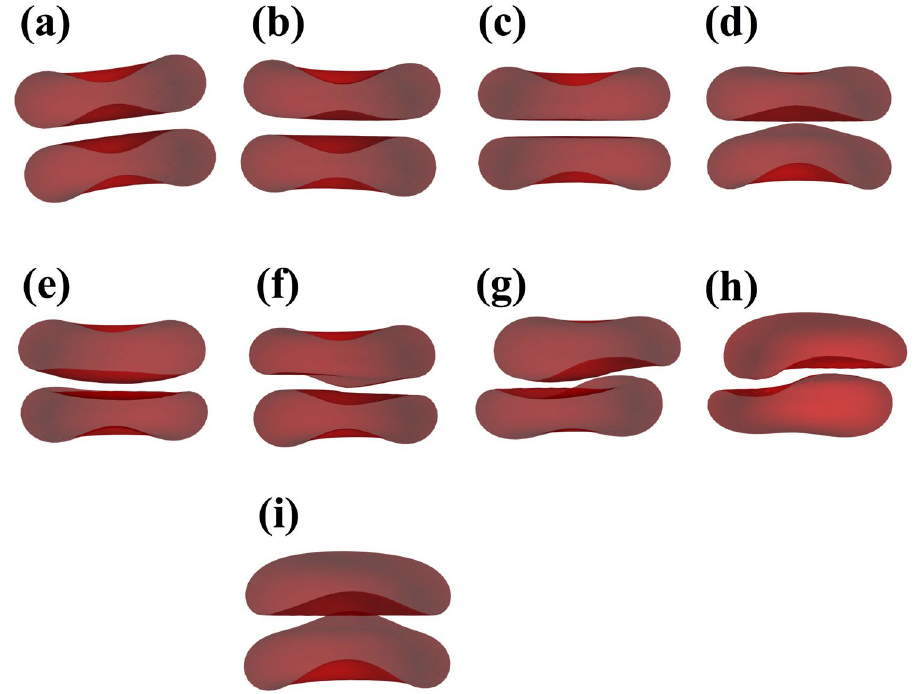
Figure 5. 3D simulations of interacting RBC doublets. ( a – h ) Identical RBCs ( ν 1 = ν 2 = 0.65) for an increasing interaction energy (in μ J/m 2 : ( a ) ε ad = 0.98, ( b ) ε ad = 1.95, ( c ) ε ad = 3.24, ( d ) ε ad = 3.90, ( e ) ε ad = 4.88, ( f ) = 6.51, ( g ) ε = 9.76, ( h ) ε = 16.3), showing a transition towards sigmoid shapes between the ( e , f ) cases. ε ad ad ad ( i ) Asymmetric case with ν